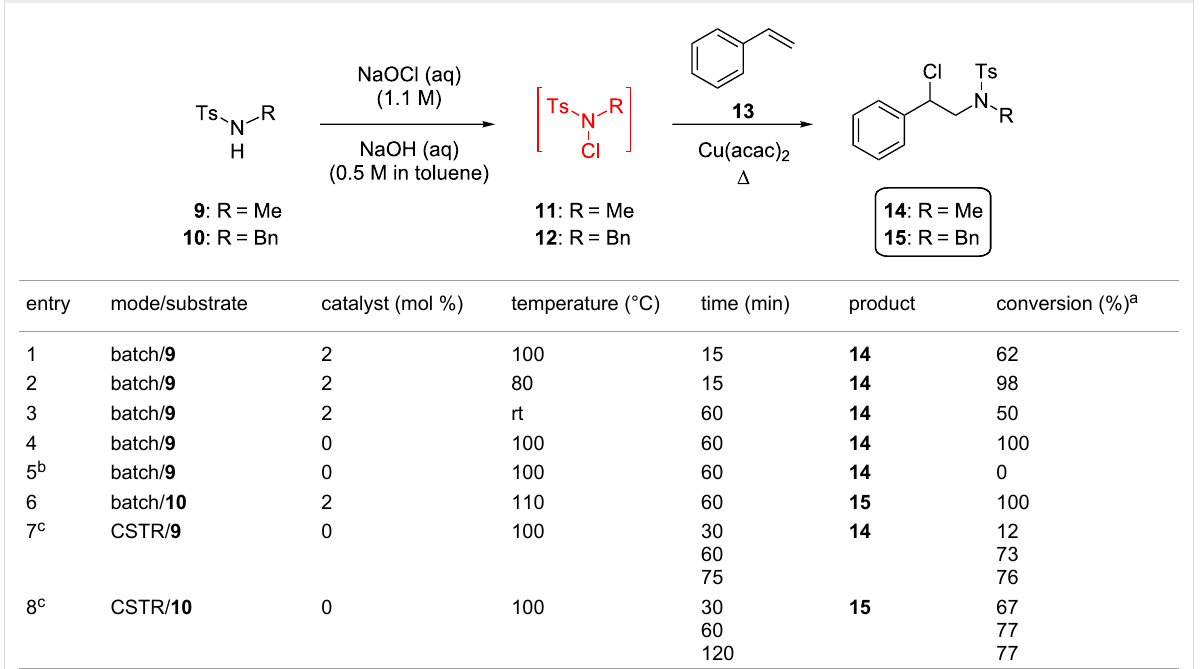
Table 2: Batch vs flow study of reaction of N- chloramine with